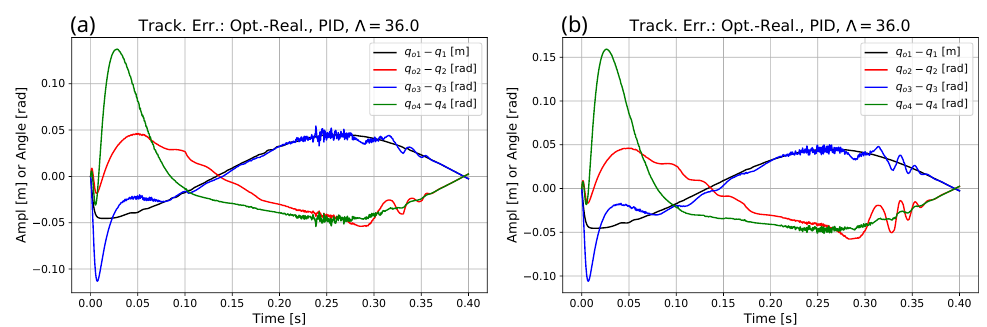
Figure 5. Nominal optimized trajectory tracking errors q N − q O without force limitation. ( a ) For set 1. ( b ) For set 2.